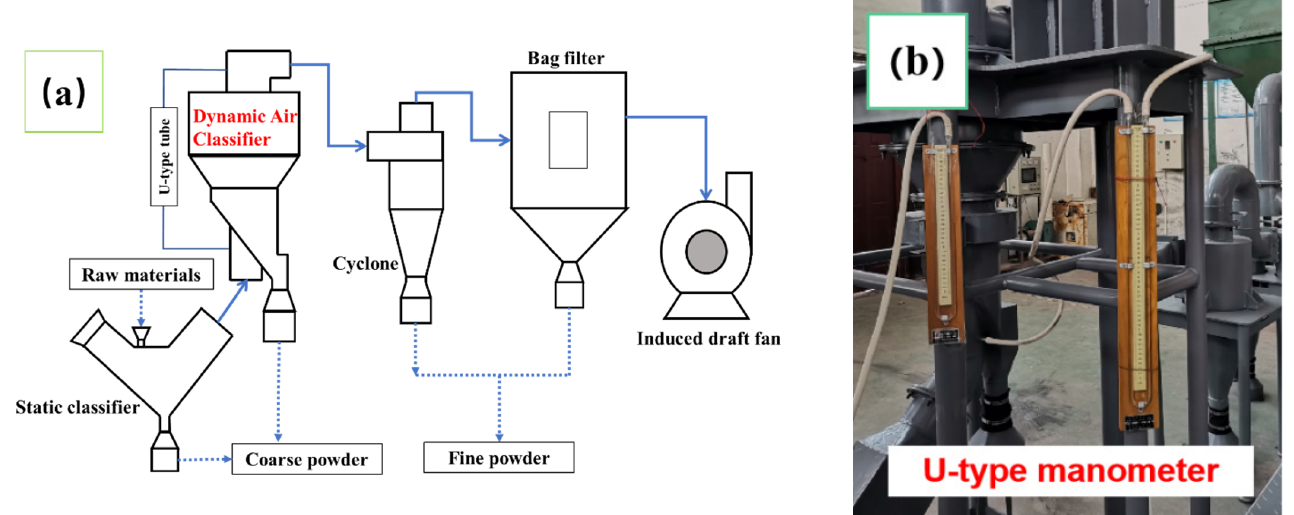
Figure 3. The classification system ( a ) and U ‐ type manometer ( b ).